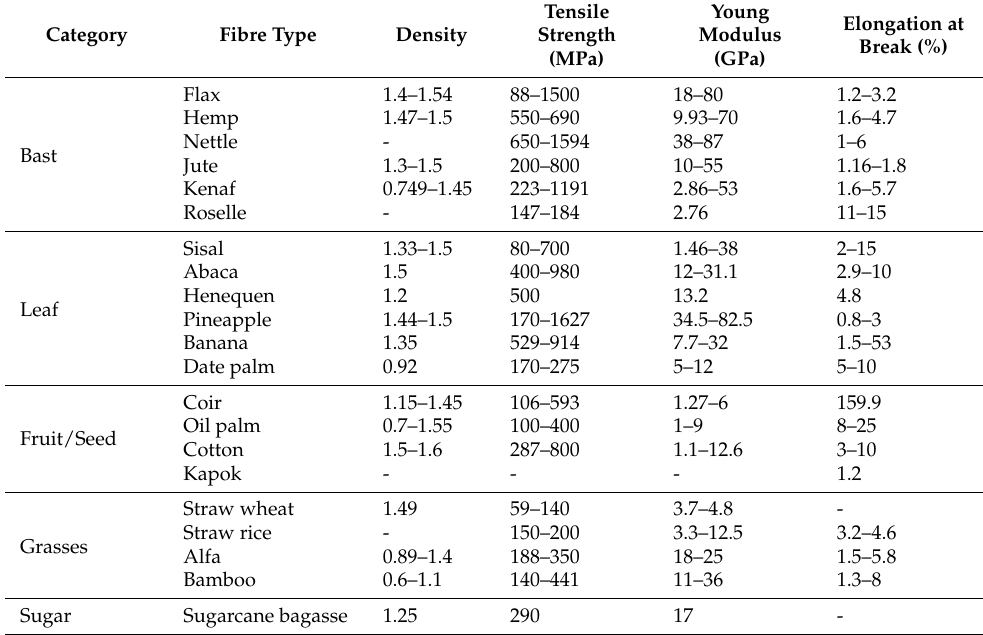
Table 7. Mechanical properties of different natural fibre